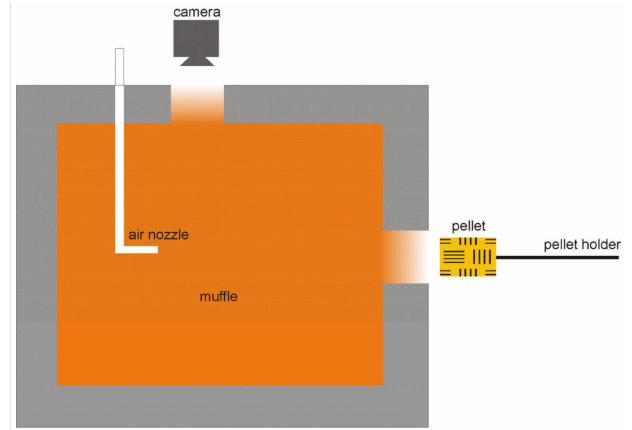
Figure 1. Experimental rig scheme.